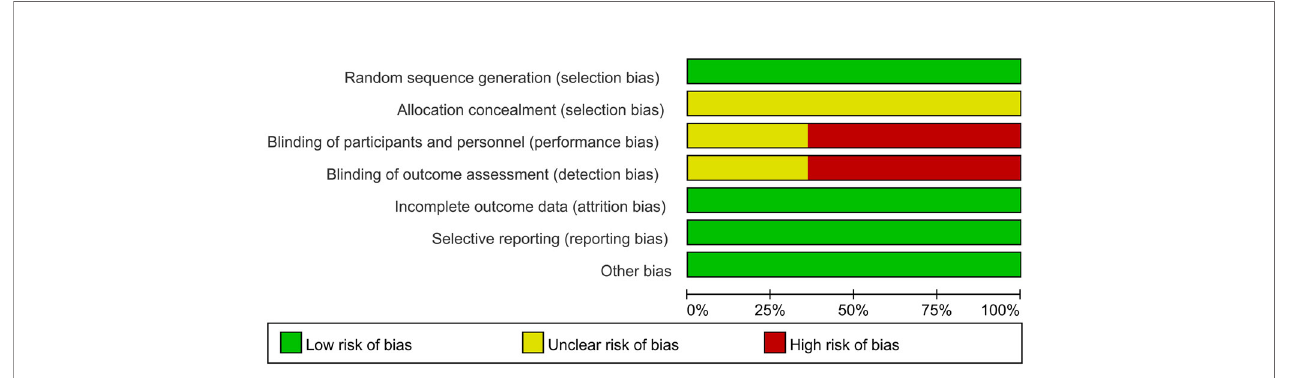
FIGURE 2 | Risk of bias graph.